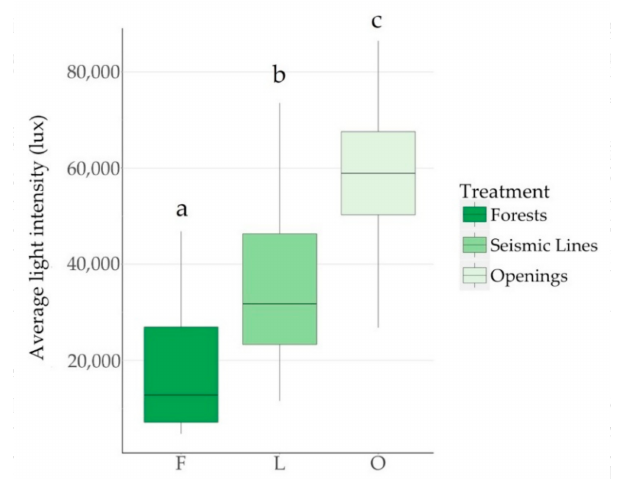
Figure 2. Box plot of average light intensity (lux) for forests (F), seismic lines (L), and openings (exploratory well pad sites) (O) for 46 sites in northeast Alberta, Canada. Post hoc Tukey tests were used to assess differences between groups with different letters signifying significant differences ( p < 0.05). Table 2. Mixed effect regression predicting average and maximum wind speed (m/s) as a function of treatment using a Gamma model transformation for 45 sites in northeast Alberta, Canada. Model